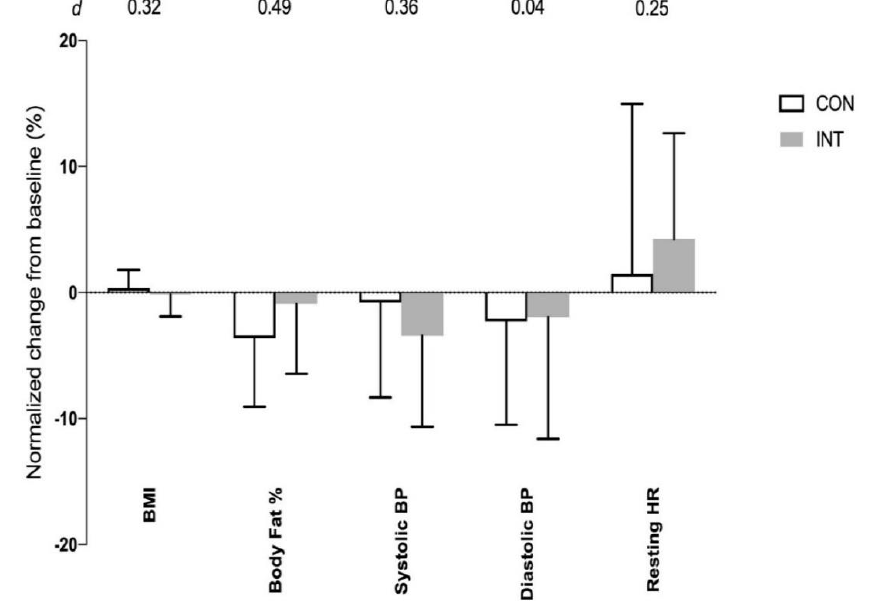
Figure 4. Normalized changes (mean ± SD) in body mass index (BMI), body fat percentage (%), systolic blood pressure (BP), diastolic BP and resting heart rate (HR) from baseline (0%) to post-6 weeks training for non-training or control (CON , N = 17) group and intervention training (INT; N = 16) group. Effect size ( d ) for the difference between CON and INT groups is shown on the top of the graph. For leg strength measures, there were interaction e ff ects for MVC at 30 extension ( F 1,31 ratio = 4.36, p = 0.045 and F 1,31 ratio = 4.42, p = 0.04, respectively), and for MVC